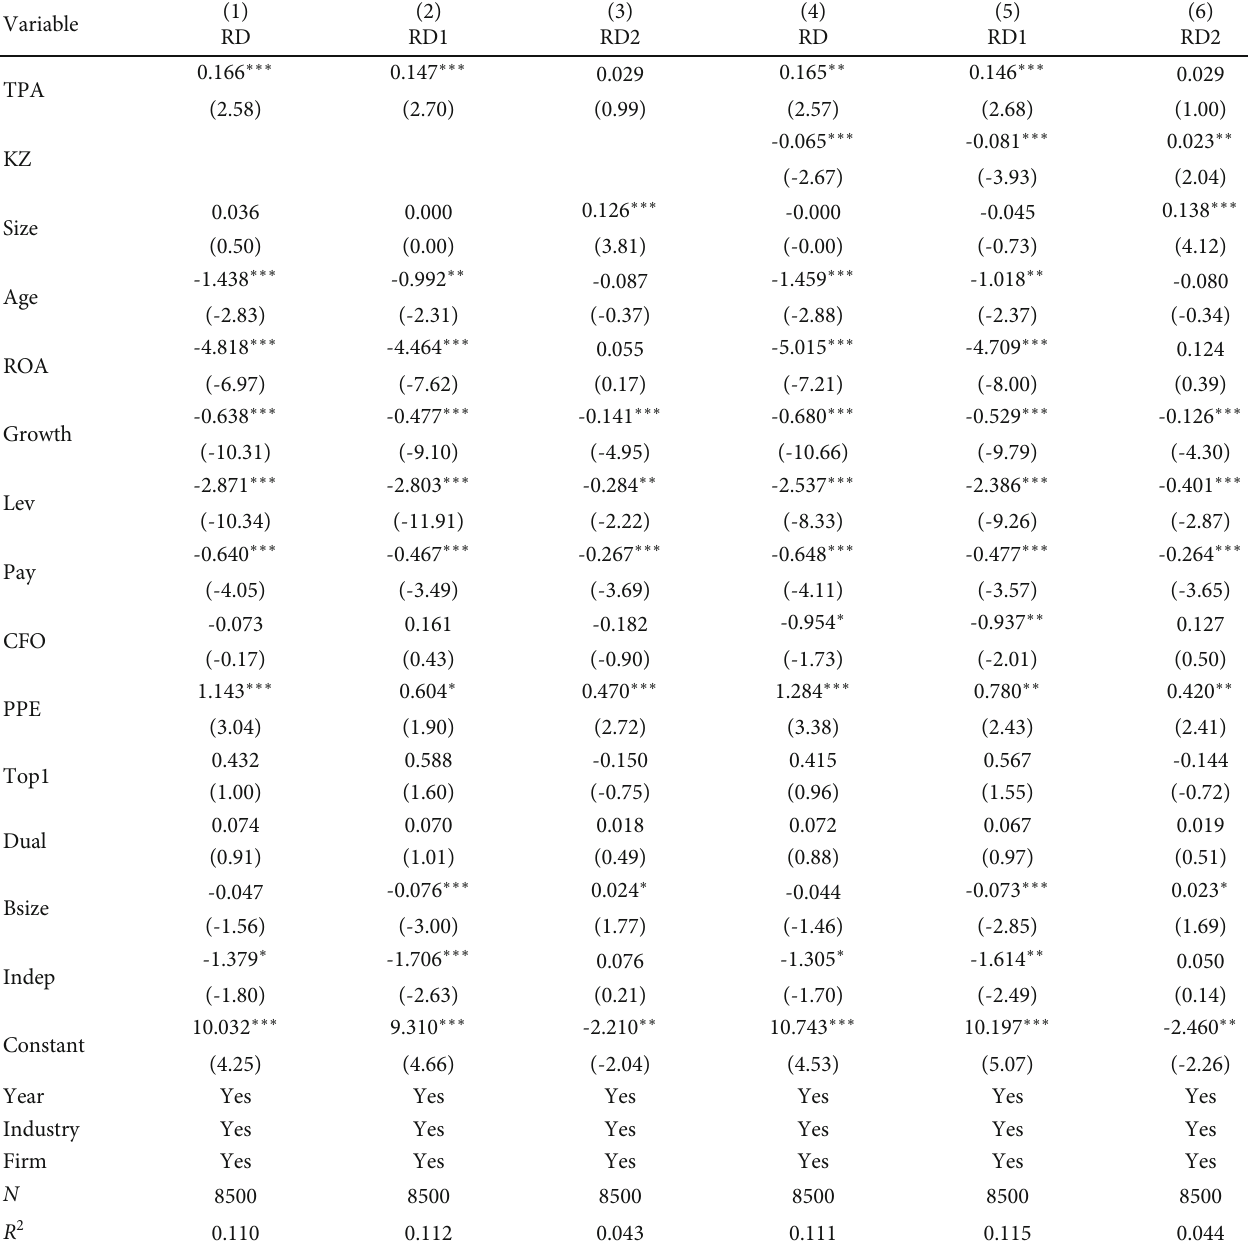
Table 7: Robustness test of model